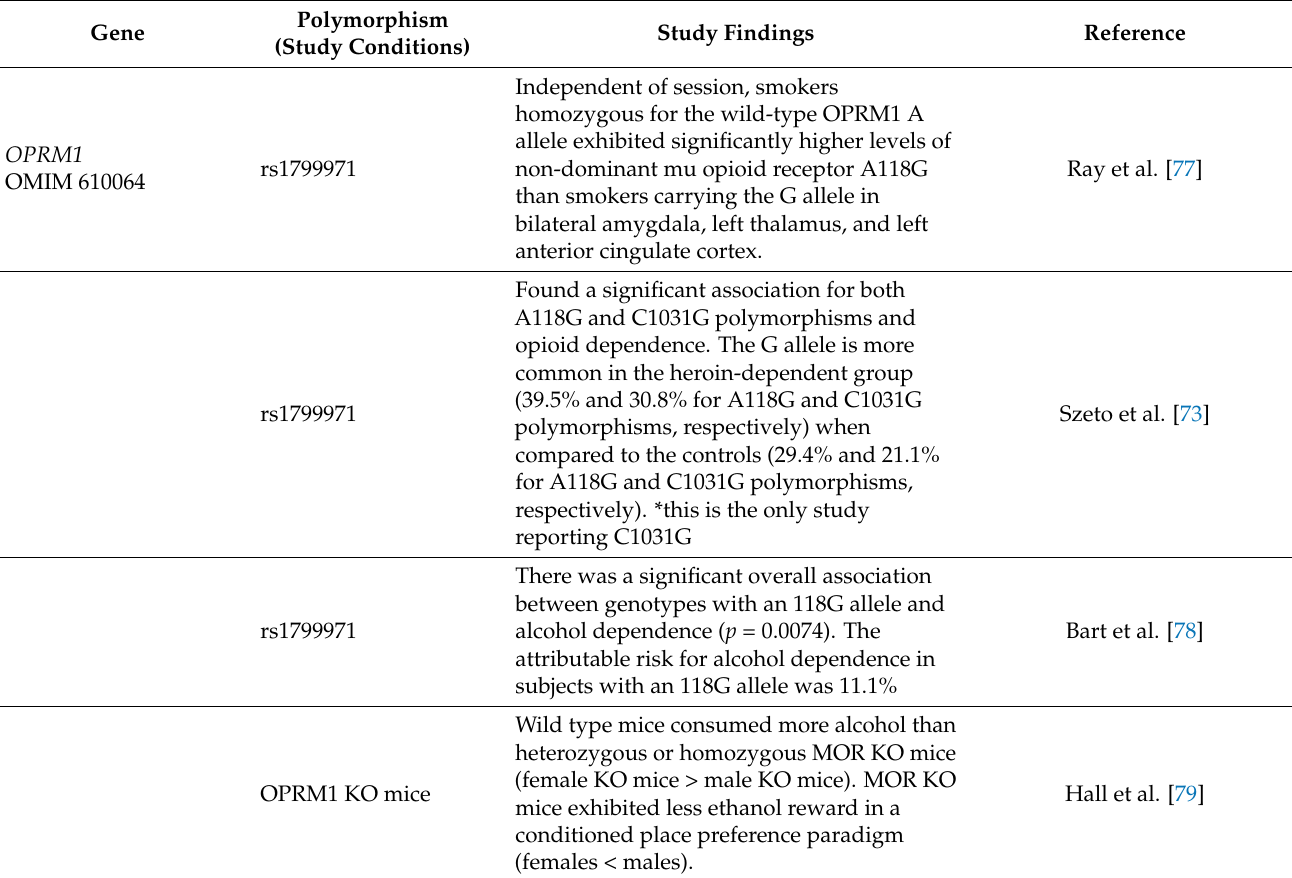
Table 2. OPRM1 gene polymorphisms and RDS—Not specific for Opioids (a